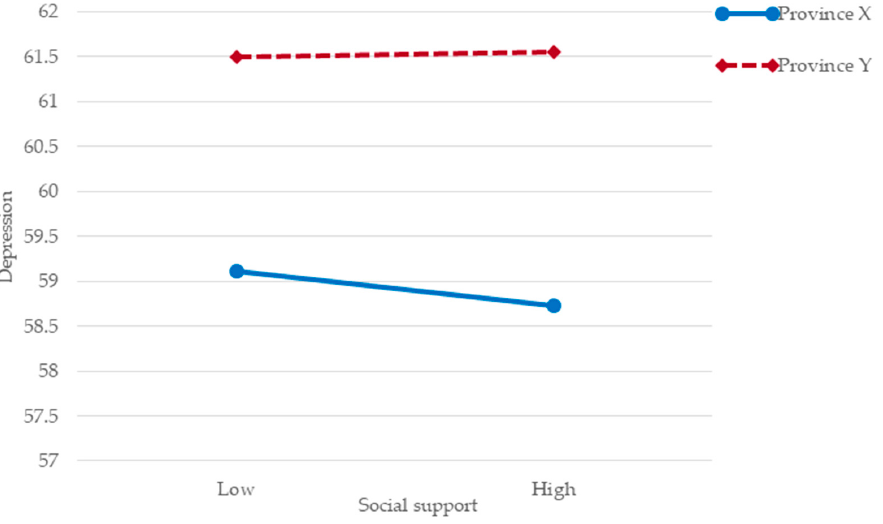
Figure 2. The moderating effect of geography among economically disadvantaged college students from provinces X and